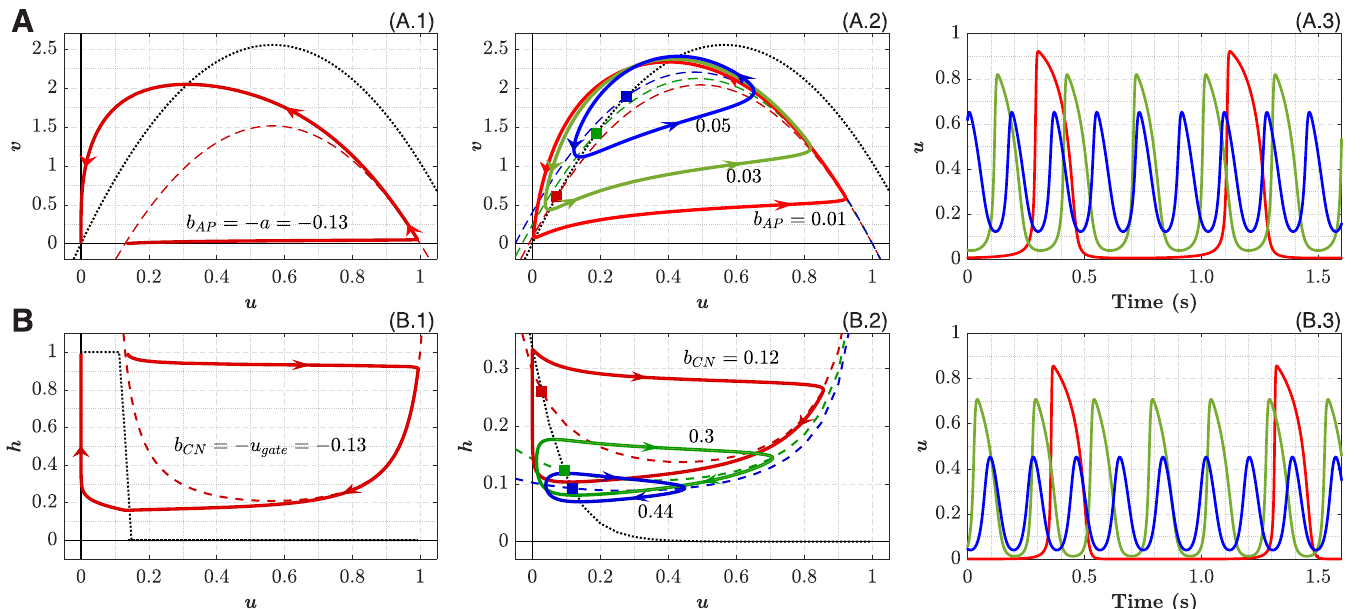
Fig 2. Single-cell nonlinear dynamics. A. AP and pAP models . A.1. Nullclines and phase portrait for the conventional AP model after suprathreshold stimulation. A.2. . Dashed and dotted lines correspond to u - and v -nullclines, respectively. Nullclines and phase portrait for the pAP model with different bifurcation parameter b AP Nullcline u = 0 is not shown. Stable limit cycles for b AP = 0.01, 0.03, and 0.05 are shown with corresponding EPs marked by squares of the same color. A.3. Action potentials, colors correspond to the curves in panel A.2. B. CN and pCN models . B.1. Nullclines and phase portrait for the conventional CN model after suprathreshold stimulation. B.2. Nullclines and phase portrait for the pCN model with different bifurcation parameter b CN . Dashed and dotted lines correspond to u - and h -nullclines, respectively. Nullcline u = 0 is not shown. Stable limit cycles for b CN = 0.12, 0.3, and 0.44 are shown with corresponding EPs marked by squares of the same color. B.3. Action potentials, colors correspond to the curves in panel